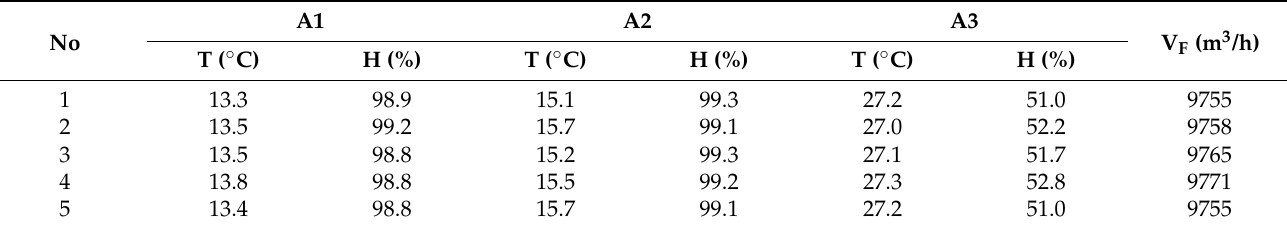
Table 16. Air side measurement result (five times).